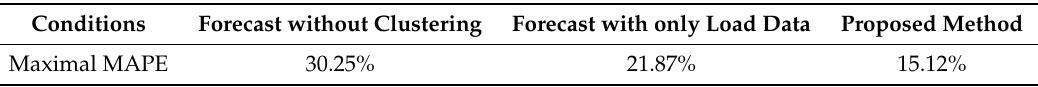
Table 9. Maximal MAPEs in different